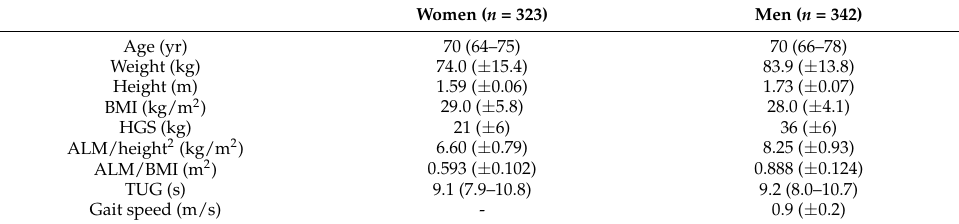
Table 2. Participant characteristics. Data are presented as mean ( ± SD) or median